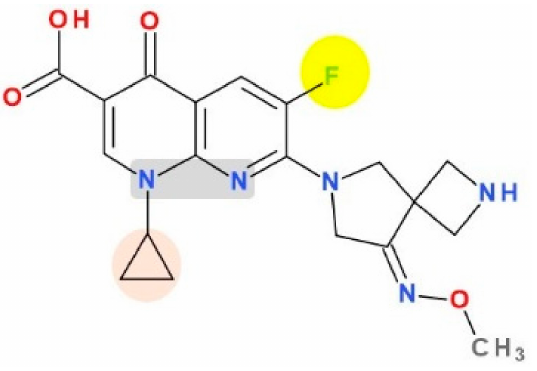
Figure 11. Chemical structure of